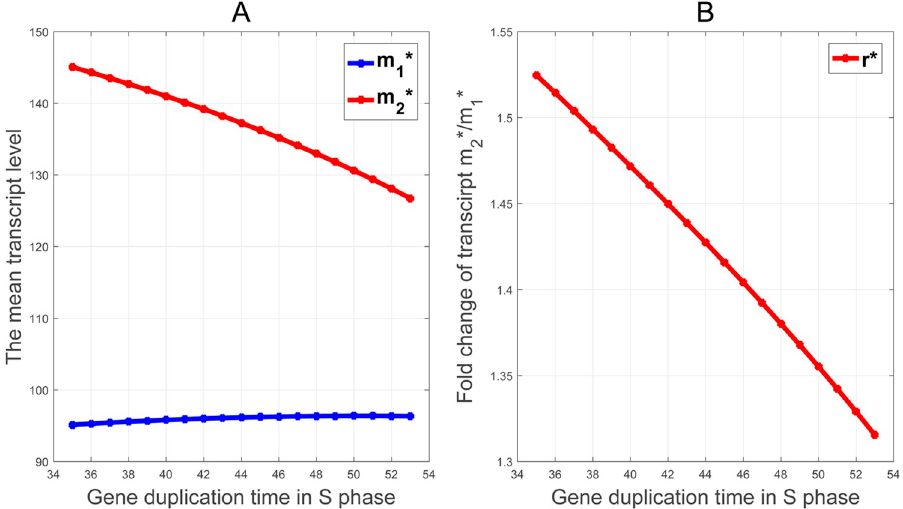
, m � and the ratio r � on the timing of gene 1 2 stays nearly at a constant level, while m � decreases linear as the 1 2